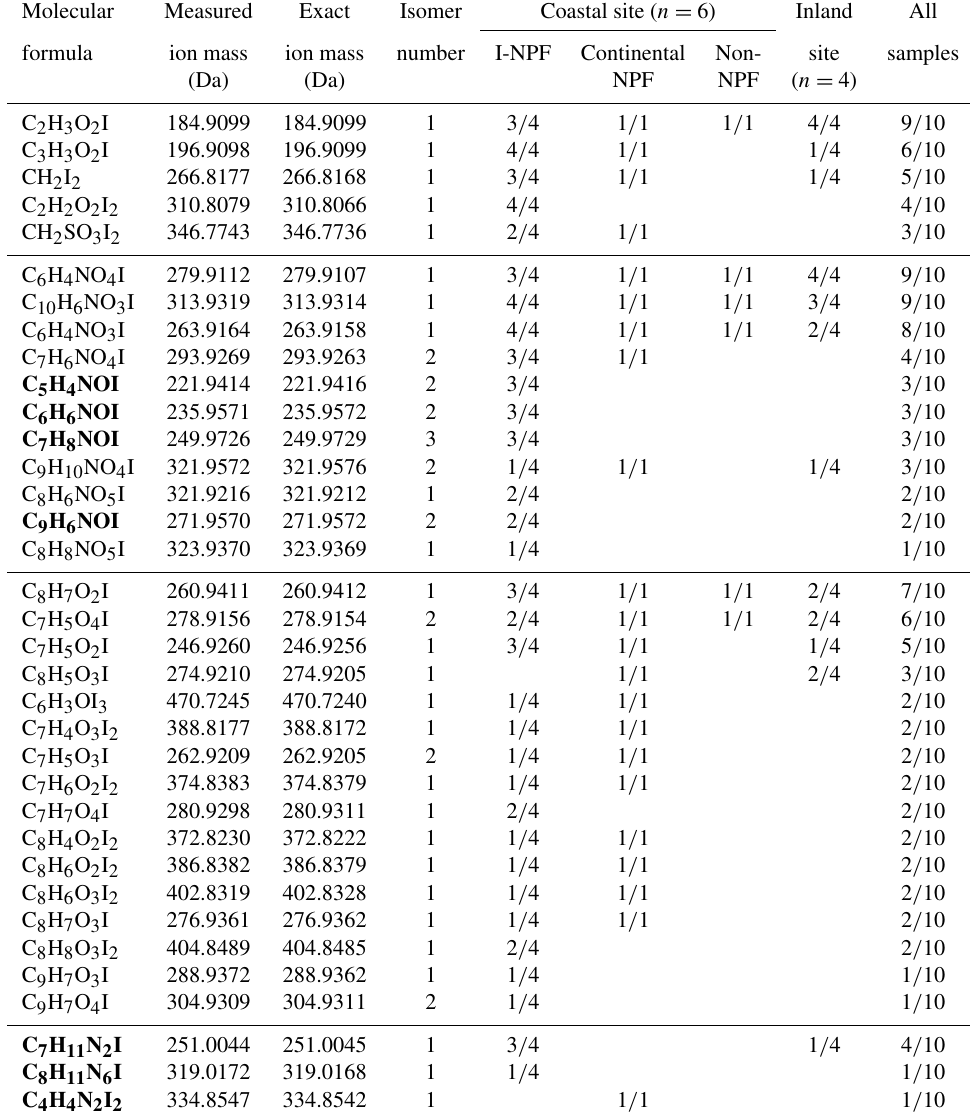
Table 1. Organic iodine compounds that were detected at least once in the aerosol samples ( n is the number of samples). Four PM 2 . 5 samples were collected at the inland site; three PM 2 . 5 samples and three sets of nano-MOUDI samples were collected at the coastal site. m/n numbers in right 4 columns: a given molecular formula was detected in m out of n samples. A blank cell means the formula was not detected in any samples. Also shown are measured ion mass, exact ion mass, and the number of isomers based on the number of chromatographic peaks observed for given ion mass in the samples. Bold formulas are observed in ESI + mode and others in ESI −